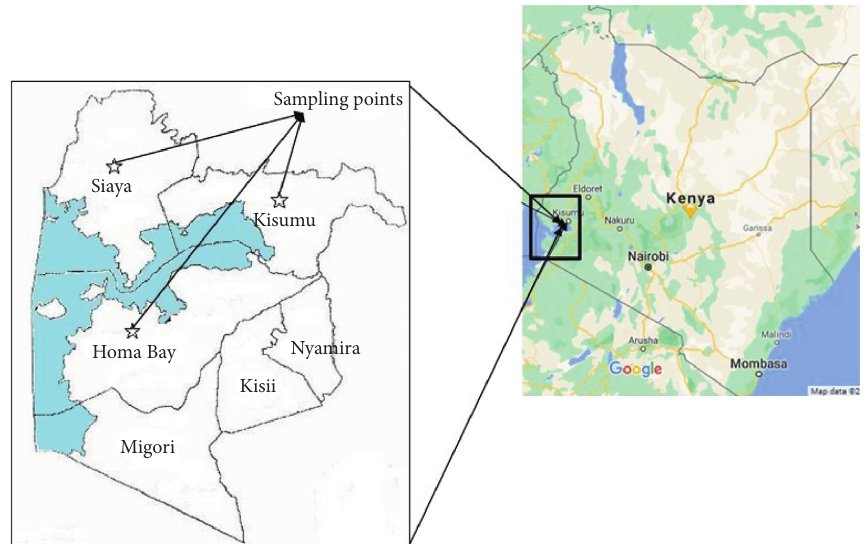
Figure 1: Map showing the study sites where C. edulis were